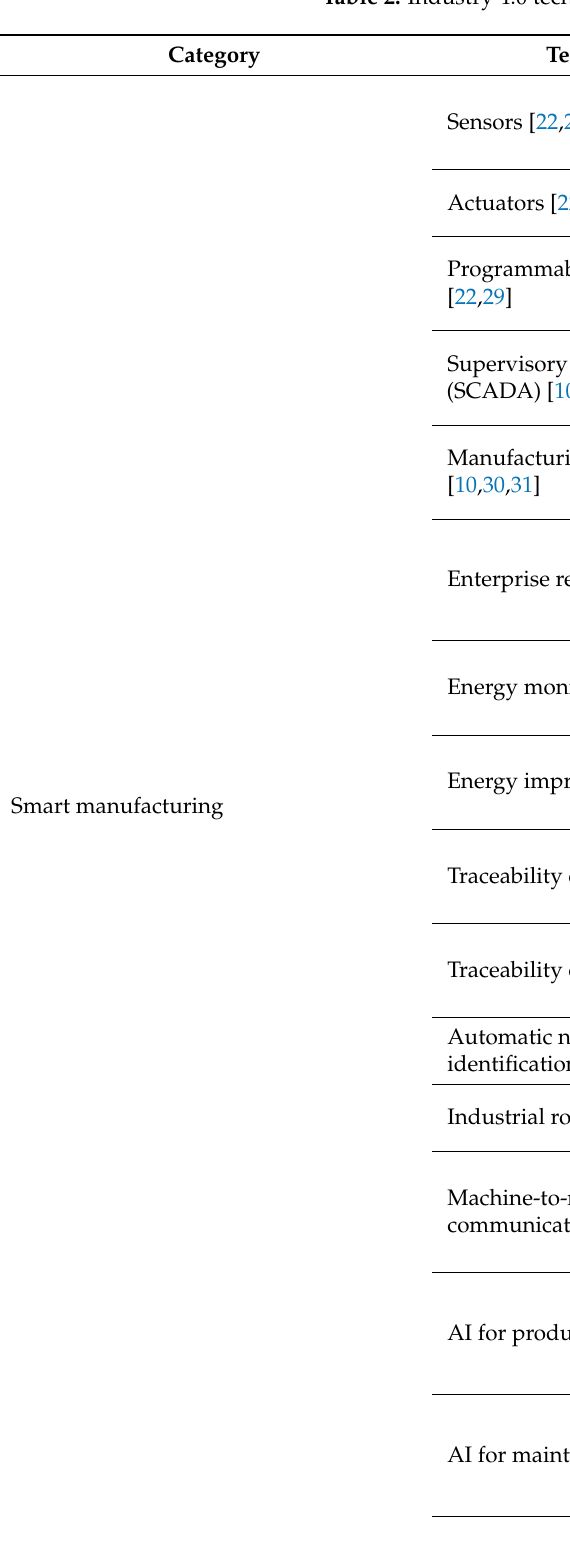
Table 2. Industry 4.0